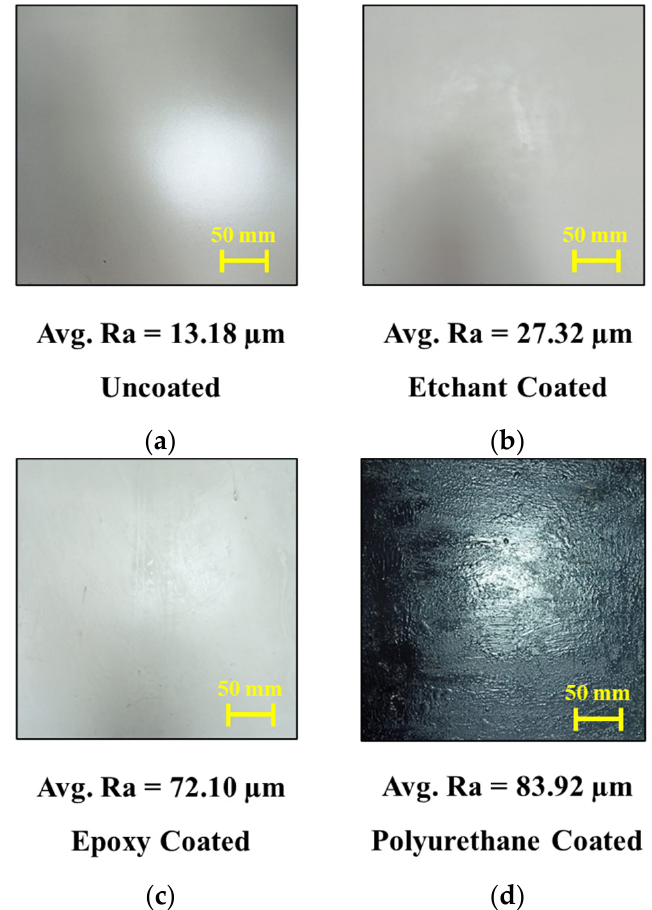
Figure 1. Floorings with surface roughness in terms of Ra: ( a ) Uncoated laminate; ( b ) Etchant-coated; ( c ) Epoxy-coated; ( d ) Polyurethane-coated.